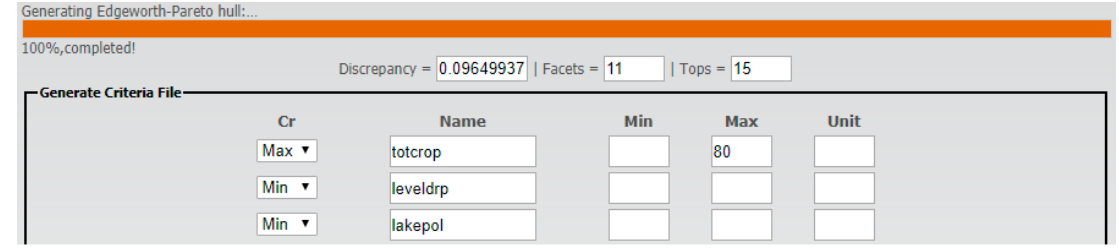
Figure 5. Web graphical user interface (wgui) to choose the criteria to maximize or minimize, define any constraints on the criteria space (in this case totcrop ≤ 80%) and generate the Edgeworth–Pareto hull. This wgui shows the discrepancy between the convergence process and the real hull, the number of facets of the hull and the number of tops of the hull.